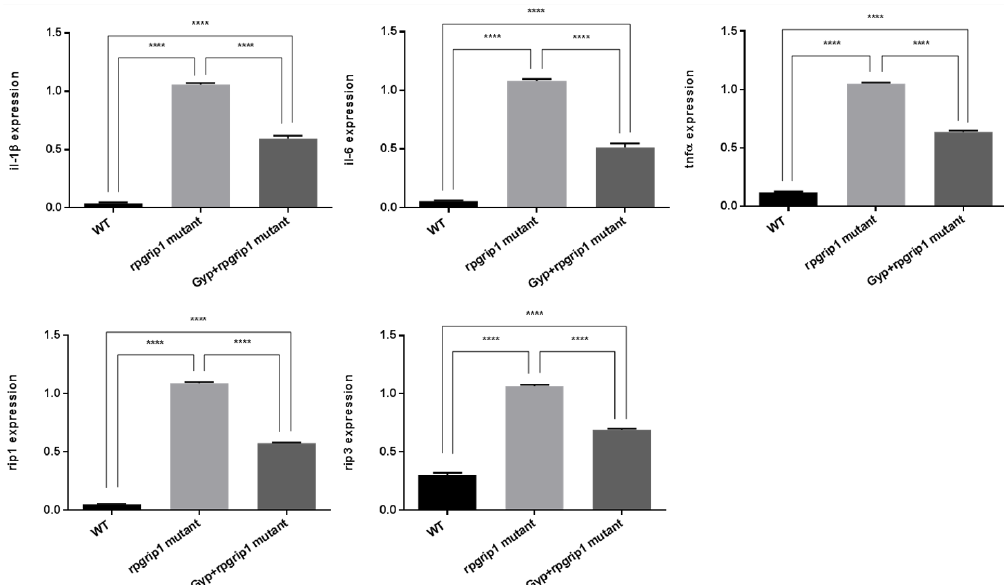
Figure 6. Gyp treatment reduced the expression of inflammation associated genes in rpgrip1 mutant zebrafish eye samples. Expression of il-1 β , il-6 , tnf α , rip1 and rip3 in eyes of wildtype (WT), untreated (UT) and Gyp-treated rpgrip1 mutant zebrafish at 6 mpf was determined by qRT-PCR. Statistical comparisons between individual groups were carried out using one-way ANOVA followed by Bonferroni’s test. Data are displayed as mean ± SEM ( n = 6 animals of each group). **** p <